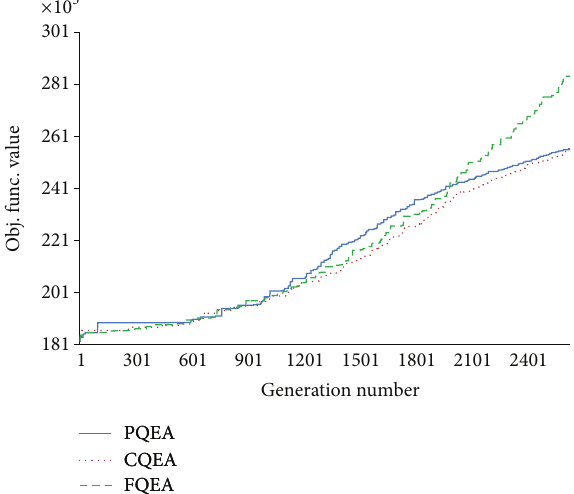
Figure 20: Convergence graph of PQEA, CQEA, and FQEA on 0-1 knapsack problem with multiple strongly correlated data instances with number of items, 𝑀 , being 5000 and capacity, 𝐶 , being 10% of total weight.